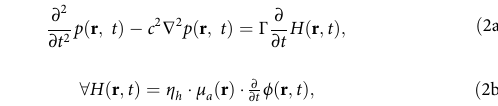
Fig. 7 Image improvement through TIR correction for experimental data of arti fi cial and biological specimens. Comparison between projections along the x , y , and z dimensions of 3D reconstructions of OR-optoacoustic microscopy images. Reconstructions were performed using conventional Hilbert transformation and TIR correction. Imaging of a gold layer (GL): a conventional reconstruction reveals strong fi eld curvature, decreased axial resolution, especially at outer parts of the imaged FOV, and repetitive signal artifacts; b TIR correction eliminates fi eld curvature and artifacts as well as signi fi cantly improves and equalizes the axial resolution throughout the FOV. Imaging of a mouse ear vasculature in vivo: c conventional reconstruction shows vessels blurred in z (see vessel *1) as well as strongly bend in z (see vessel *2); d TIR correction let vessel appear smooth (*1) and levelled (*2). Zoomed-in view of the indicated ROI, showing a microcapillary. Conventional reconstruction yields an elongated microcapillary in z , whereas TIR correction approximates a presumably circular microcapillary more accurate. Imaging of an isolated red blood cell (RBC) in vitro: e conventional reconstruction leads to an axially elongated RBC; f the TIR-corrected RBC appears fl atter and smoother. Imaging of a zebra fi sh brain vasculature in vivo: g conventional reconstruction shows blurry vessels (see vessel *3); h TIR correction leads to a sharp vessel (*3). Scale bars, 100 µ m ( a – d , g ) or 5 µ m ( c , d zoom-in, e , f ); shadows in d , f zoom- ins are c , e zoom-ins,